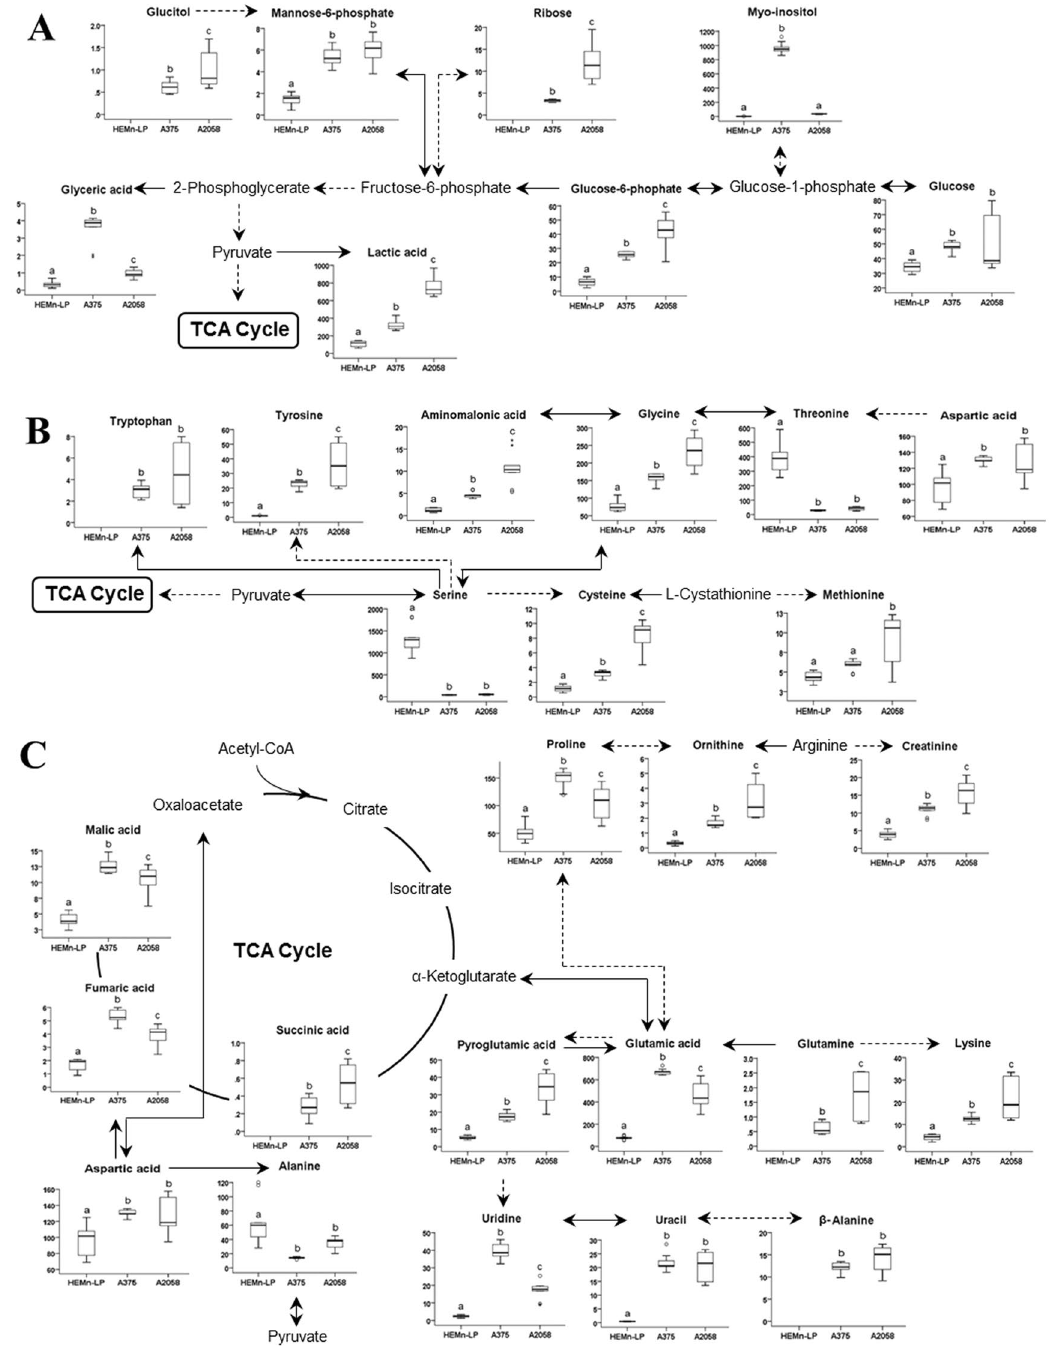
Figure 6. Metabolic changes and associated pathways in melanocytes and melanoma cells with different metastatic potential (HEMn-LP, A375, A2058), as determined by gas chromatography-mass spectrometry. Major pathways associated with melanoma metastasis, ( A ) glycolysis, ( B ) glycine, serine and threonine metabolism, and cysteine and methionine metabolism, ( C ) alanine, aspartate and glutamate metabolism, arginine and proline metabolism, and β -alanine metabolism were identified. Metabolic pathways were proposed based on a comparison with data in the KEGG database (http://www.genome.jp/kegg/). ANOVA, followed by Tukey’s post-hoc test ( p < 0.05), was conducted, and different letters indicate statistically significant differences between